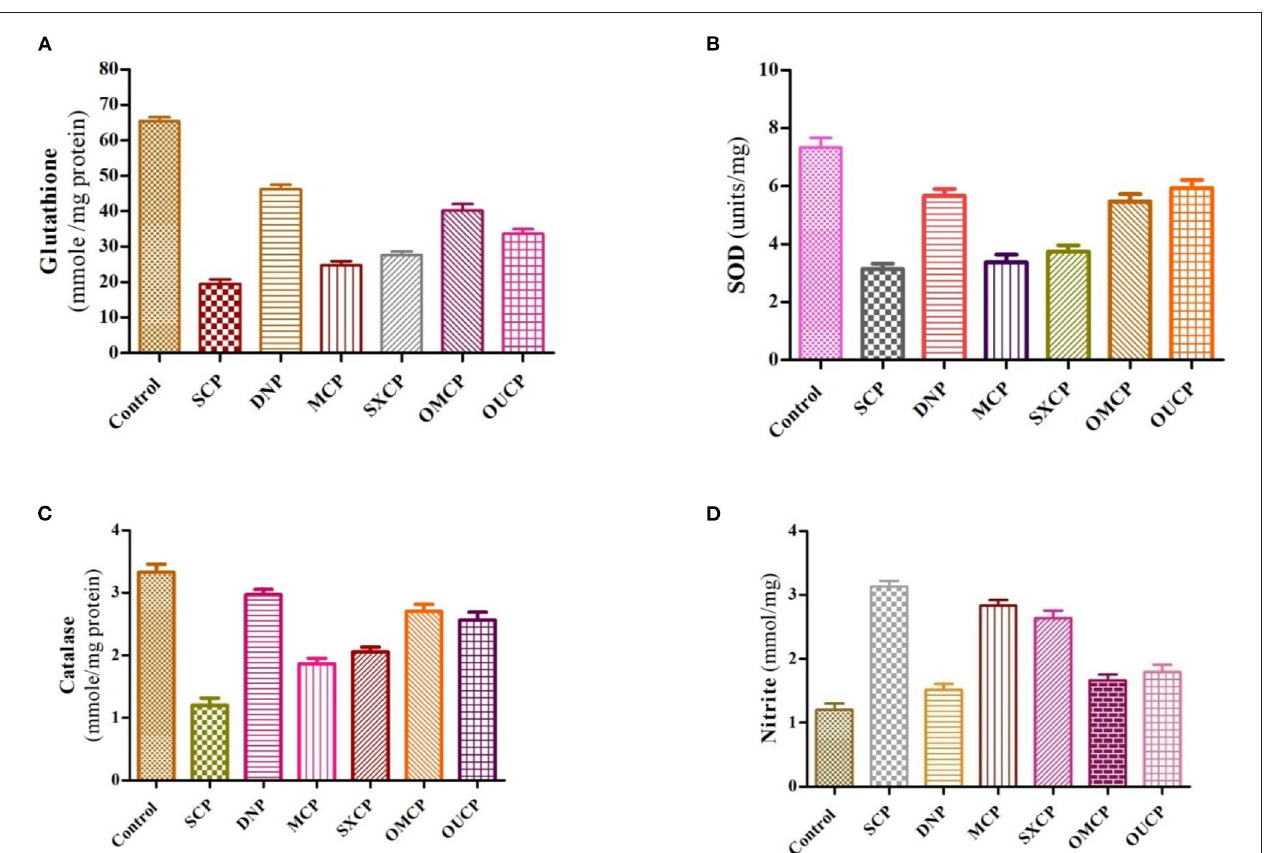
FIGURE 10 | Biochemical estimation of different anti-oxidant stress parameters (A) reduced glutathione (B) SOD (C) catalase (D) nitrite content in various groups.